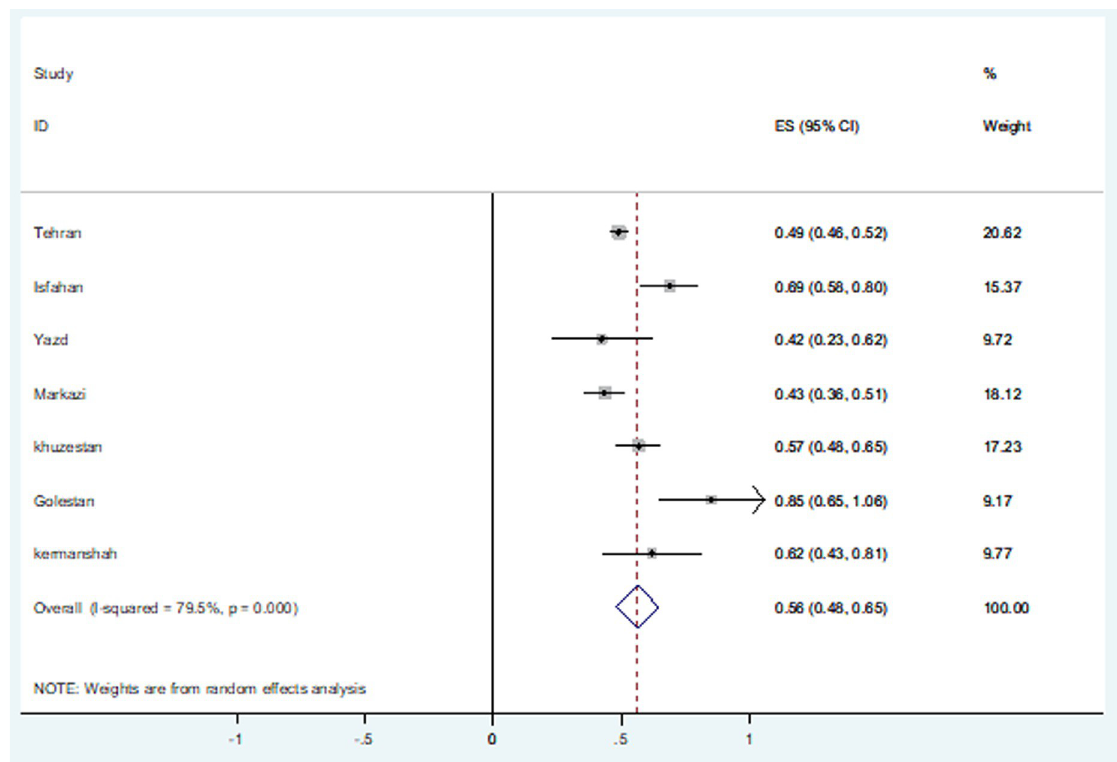
Fig 4. Forest chart of meta-analysis of Nocardia prevalence by provinces of Iran based on random effects model.